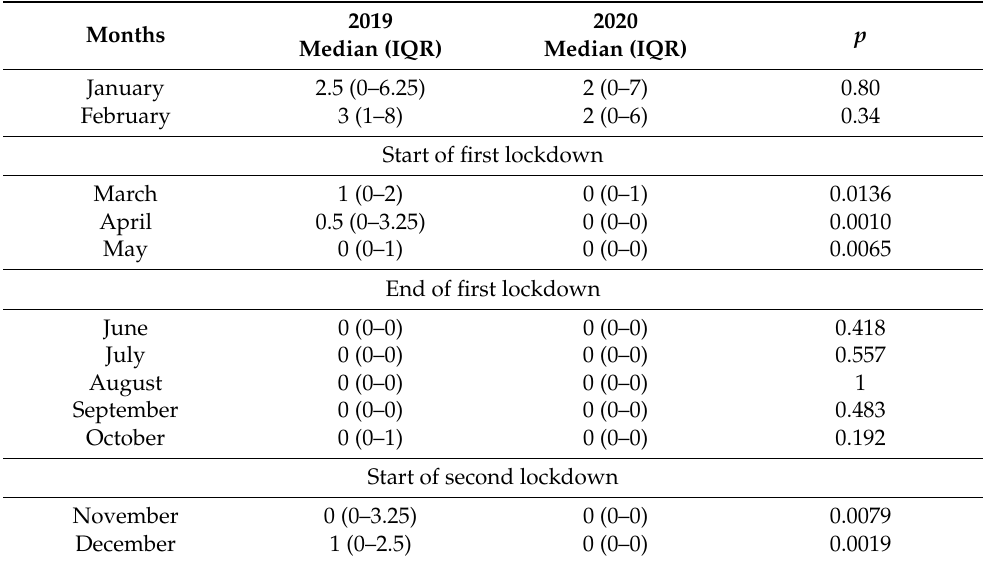
Table 1. Number of patients with bronchiolitis recorded monthly in 2019 compared to 2020, in the study population of 35,787 children aged 0–14 years.